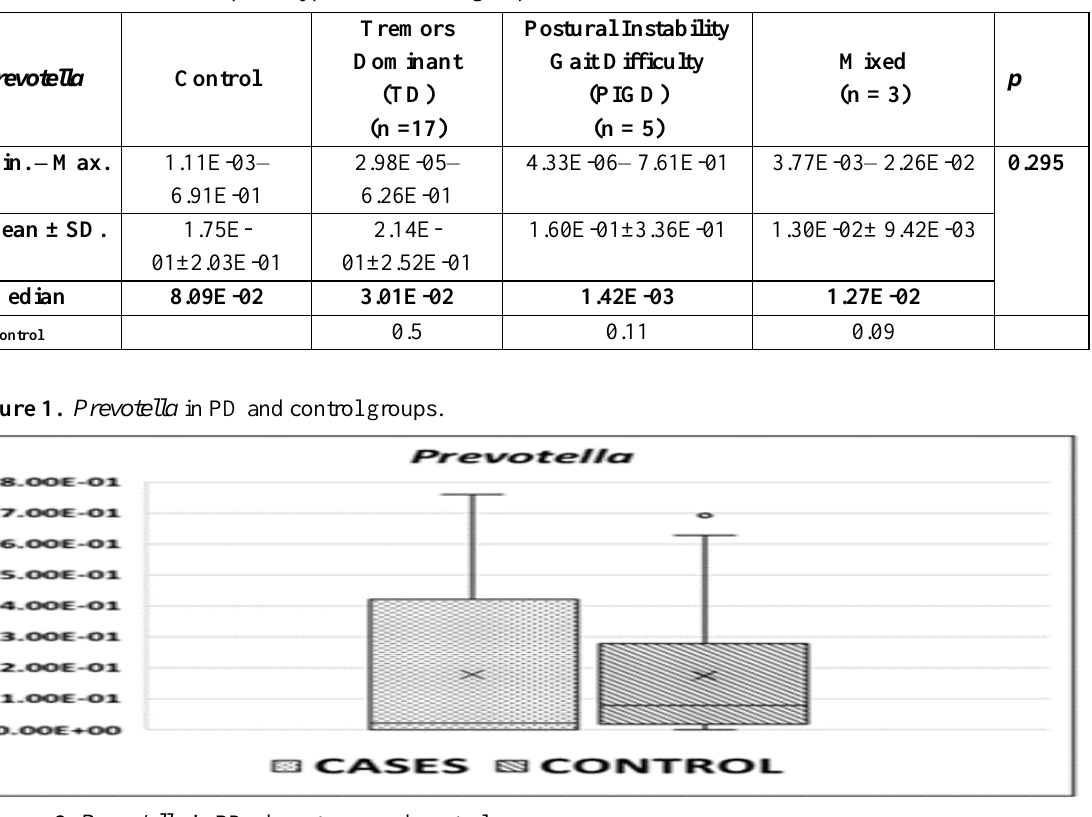
Figure 2 . Prevotella in PD phenotypes and control group .